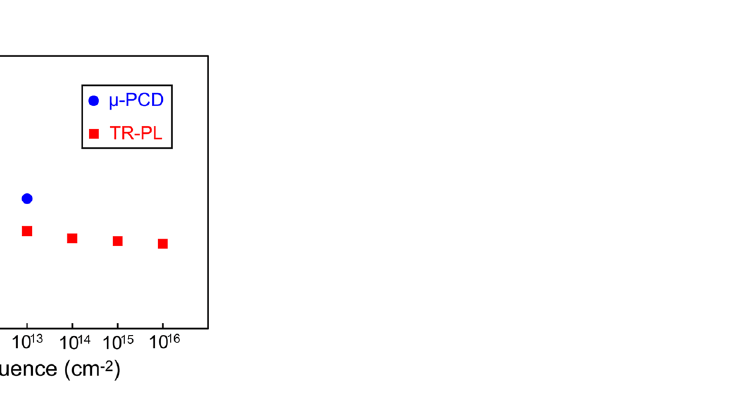
Figure 5. Carrier lifetime dependence on proton fluence measured by TR-PL and μ-PCD. The number of the measured specimens were 4 for non-irradiated specimens and 1 for other